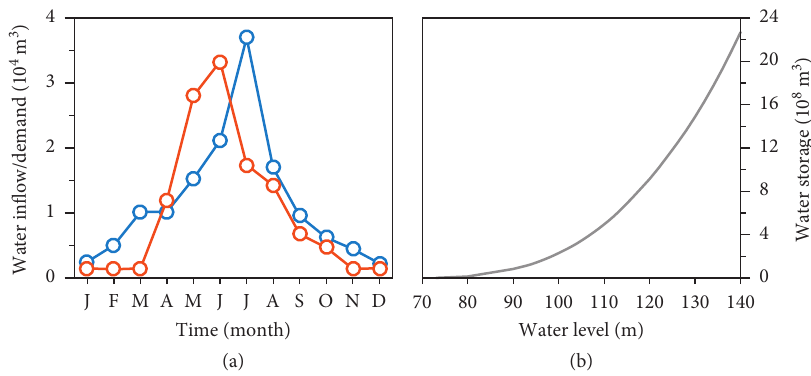
Figure 3: (a) Monthly water inflow (blue) and demand (orange) and (b) the elevation-volume